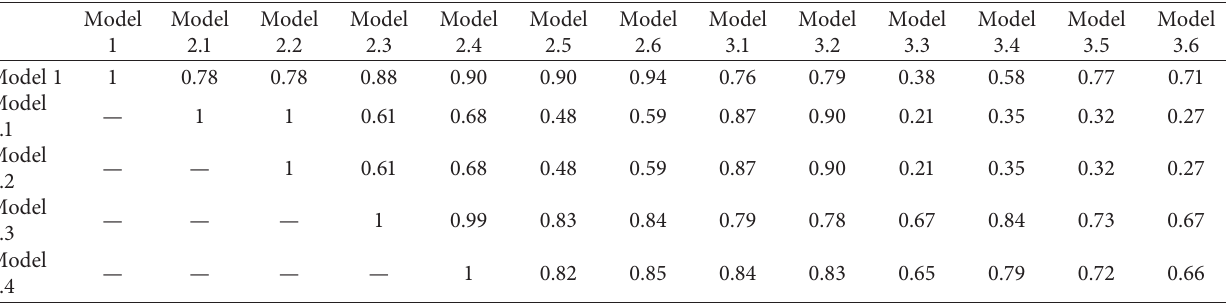
Table 20: Correlation of the ranks in the models 1, 2, and